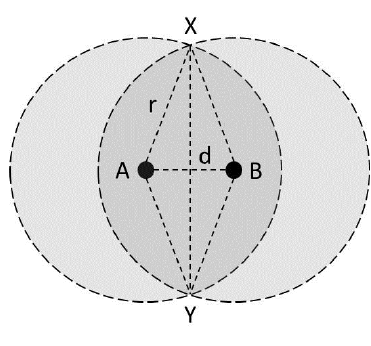
Figure 4. OCR calculation method, overlapped area among two BSSs’ signal coverage can be calculated by measuring the distance between the